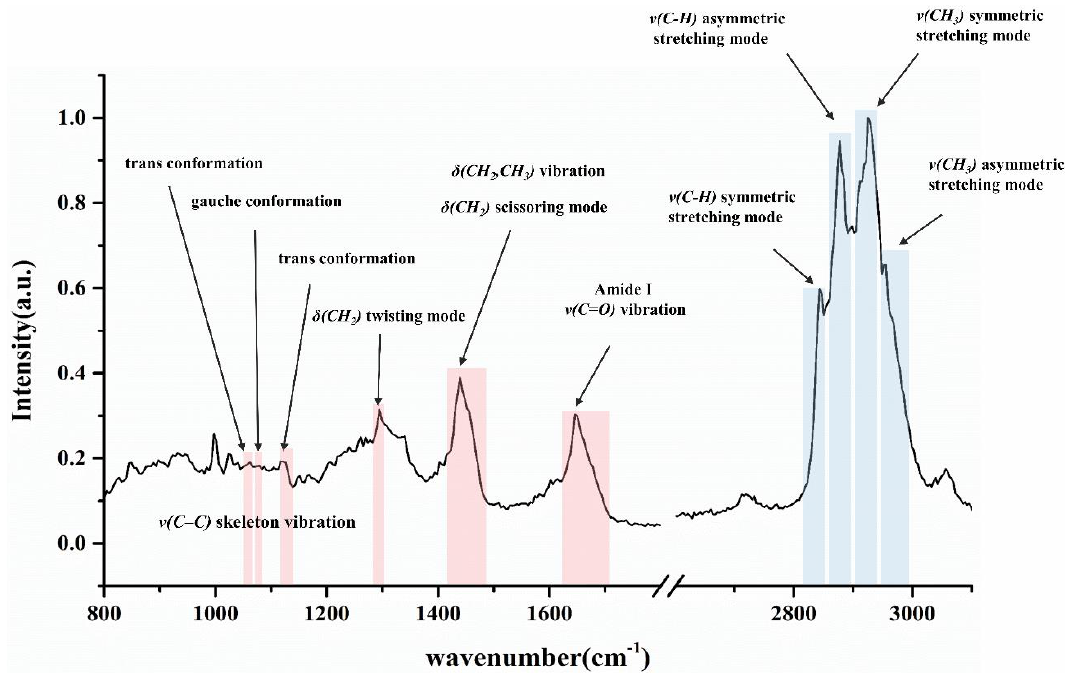
Figure 1. Major band assignments of CRS spectrum obtained from skin sample. The red/blue areas represent the specific peak referring to different molecular vibrations. The break on the axis of wavenumber separates the fingerprint region (left side) and high wavenumber region (right side). The peaks assigned to trans and gauche conformations are both originated from C–C skeleton vibration.